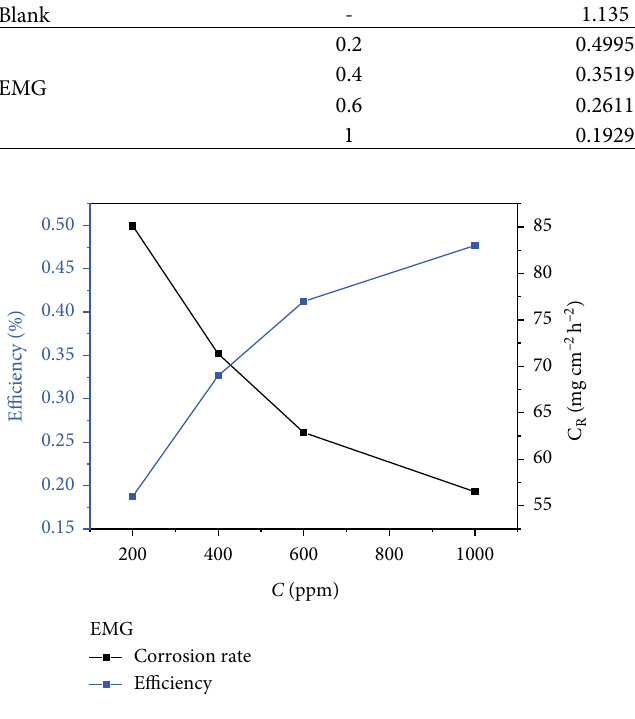
Figure 3: Variation in corrosion rate and inhibition efficiency of mild steel in 1.0 M HCl with different concentrations of EMG after 6 hours of immersion.